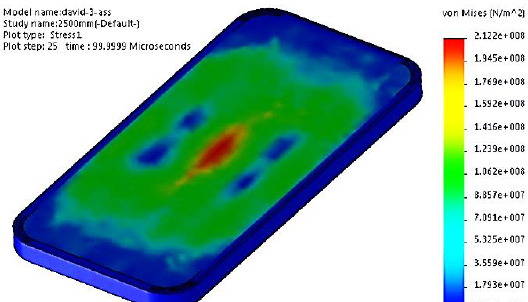
Fig. 5. Stress Distribution for a cellphone with Three Casing Laminate at 2500mm Drop Height.